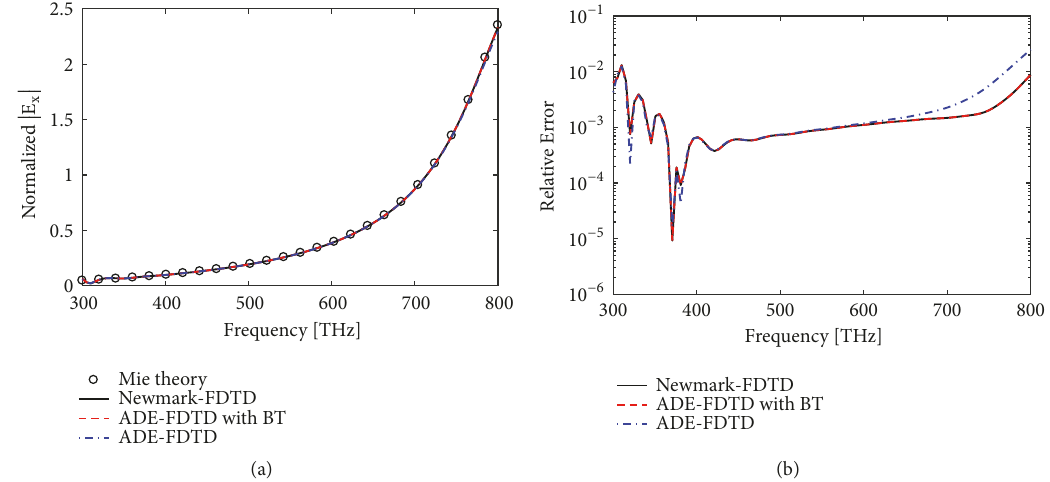
Figure 4: 3D FDTD simulations for an Ag nanosphere with the radius of 40nm. (a) Spectral response. (b) Relative